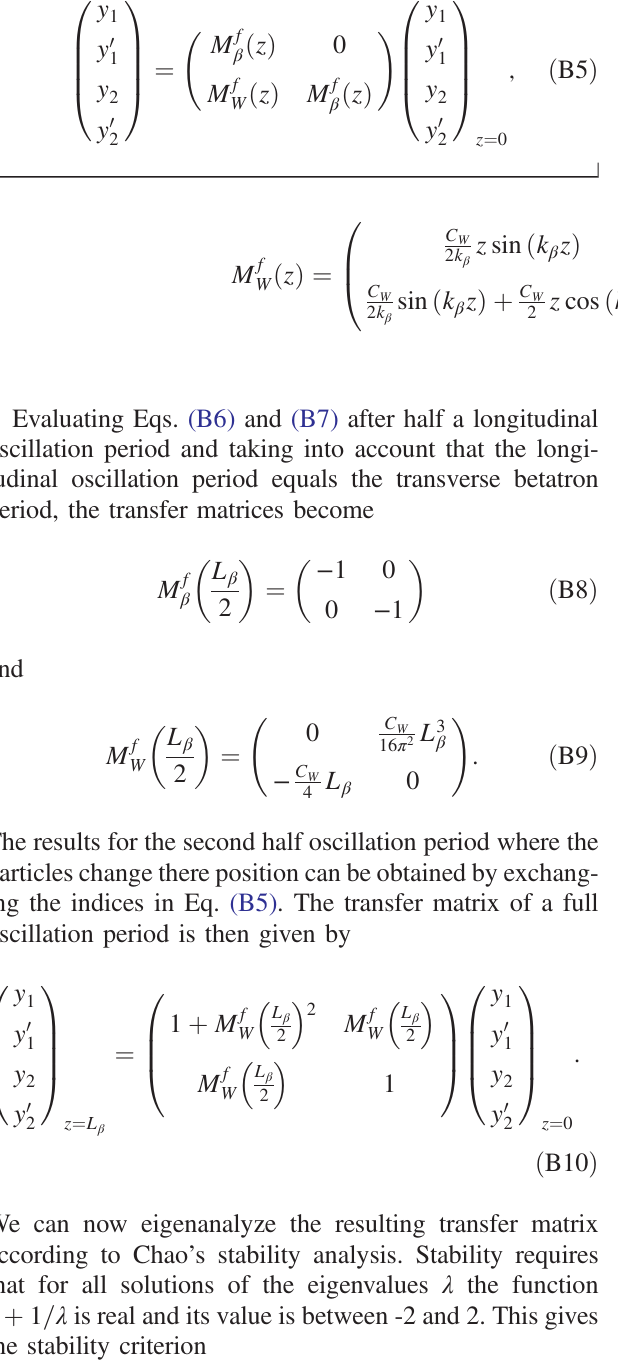
FIG. 16. Two-particle model in smooth approximation. For a small initial offset, a transversely stable bunch has a sinusoidal envelope (yellow line) and an unstable bunch has an exponen- tially growing amplitude (red line). The y-offsets of both macro- particles (MP1 and MP2) are plotted respectively. The initial excitation without wake is shown for comparison